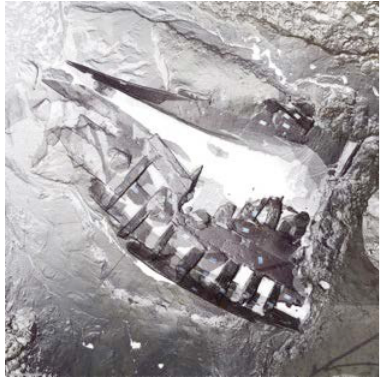
Figure 17. Ortho-photo of the